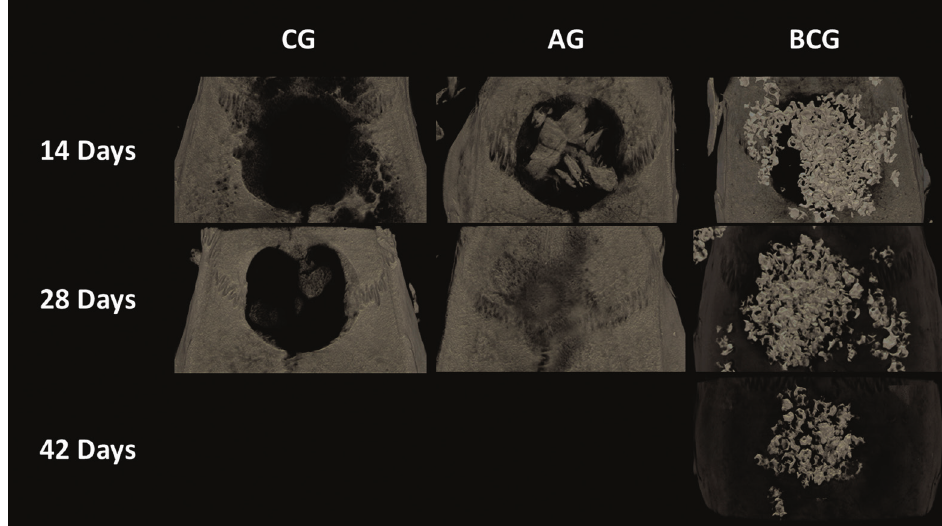
Figure 9- Images obtained by μCT of CG, AG, and BCG (14, 28 and 42 days). Bone neoformation was observed with total filling of defect at 28 days in GA. BCG promoted filling of defect with the biomaterial until the 42-day period